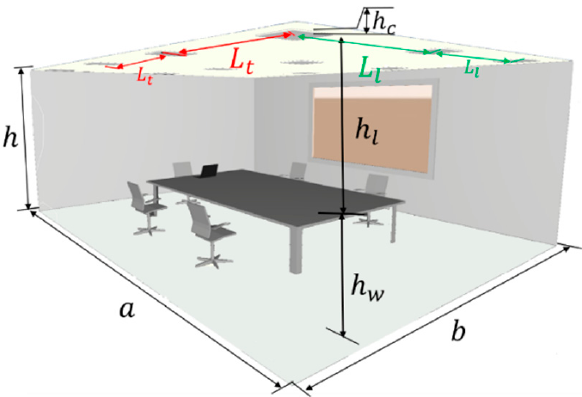
h Figure 2. Room diagram. a , b and h are the length, width and height of the room; h w , h l , and h c are